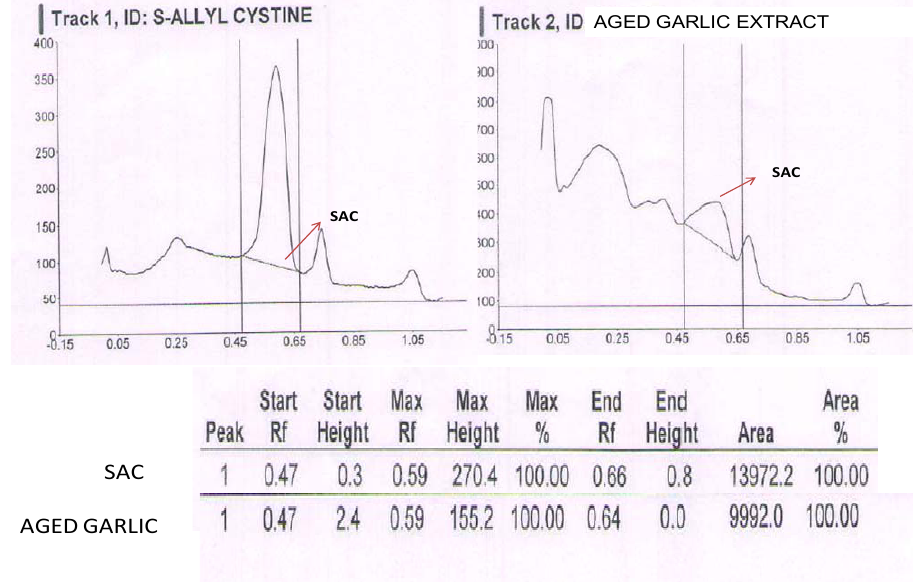
Figure 1. Typical chromatogram of standard S ‐ allyl cysteine (SAC) and aged garlic extract.